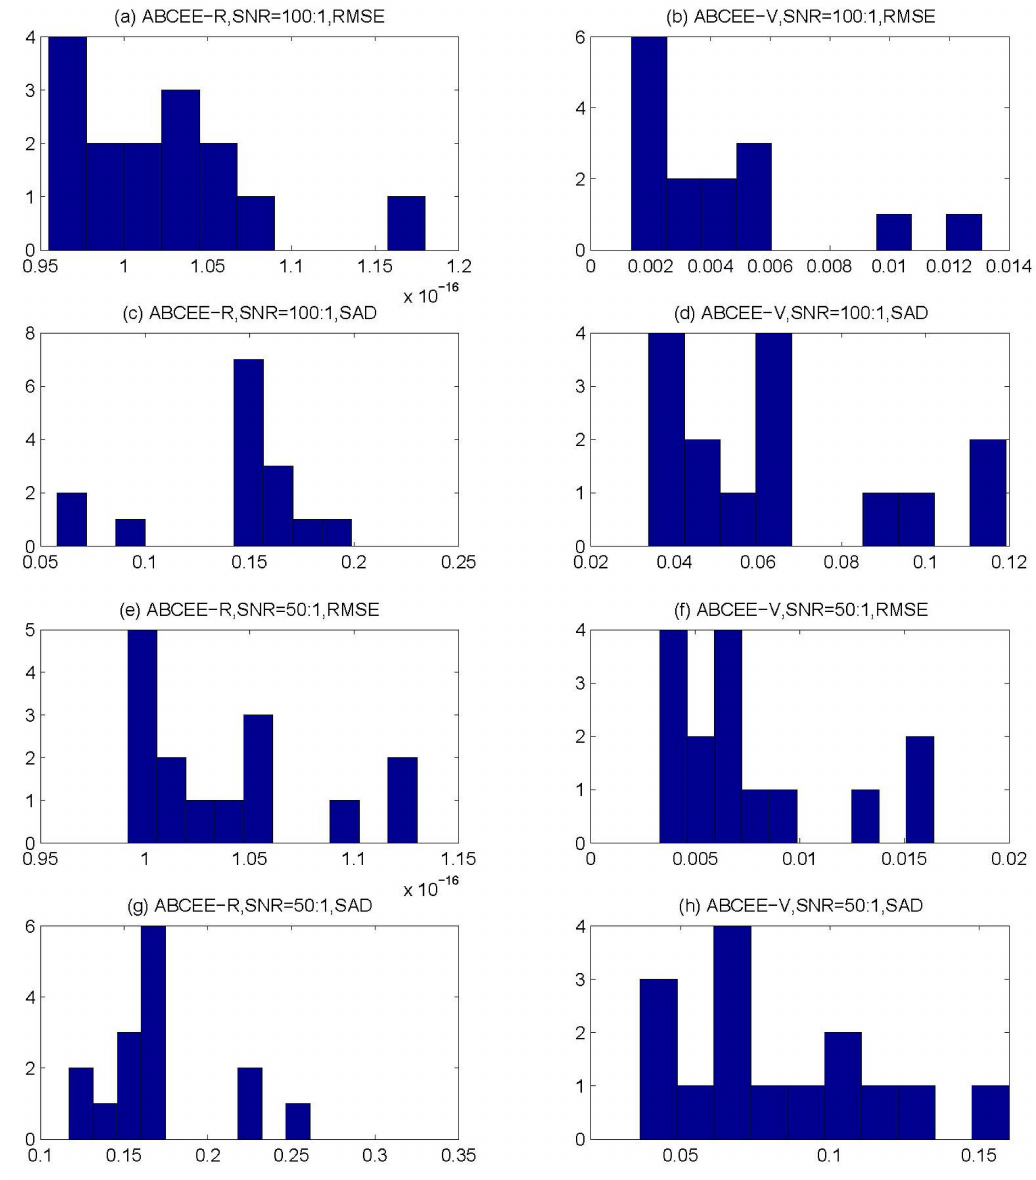
Figure 7. Hist of the synthetic Dataset 3. ( a ) ABCEE-R, SNR=100:1, RMSE; ( b ) ABCEE-V, SNR=100:1, RMSE; ( c ) ABCEE-R, SNR=100:1, SAD; ( d ) ABCEE-V, SNR=100:1, SAD; ( e ) ABCEE-R, SNR=50:1, RMSE; ( f ) ABCEE-V, SNR=50:1, RMSE; ( g ) ABCEE-R, SNR=50:1, SAD; ( h ) ABCEE-V, SNR=50:1,